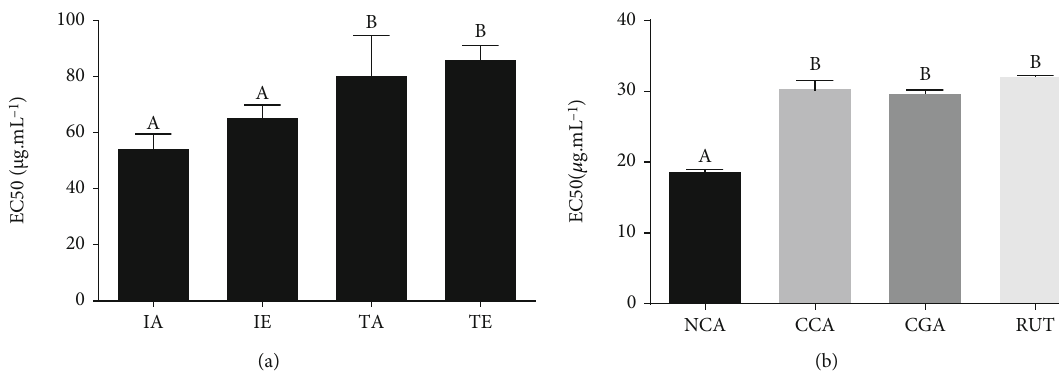
Figure 4: Radical scavenging by DPPH assay expressed in EC : (a) extracts and (b) compounds. Di ff erent letters (A, B) indicate signi fi cant 50 di ff erence (ANOVA, followed by Tukey test; p < 0 : 05 ). Note: IA: aqueous infusion; IE: hydroethanolic infusion; TA: aqueous turboextraction; TE: hydroethanolic turboextraction; NCA: neochlorogenic acid; CCA: cryptochlorogenic acid; CGA: chlorogenic acid; RUT: rutin.